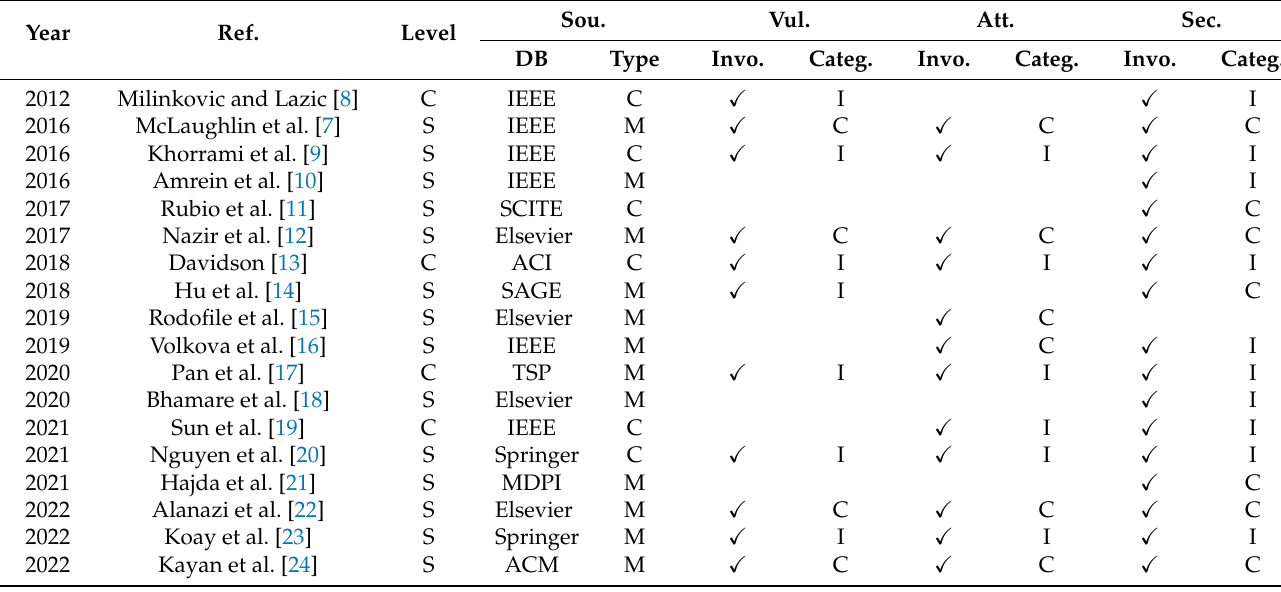
Table A1. Comparison with existing surveys.